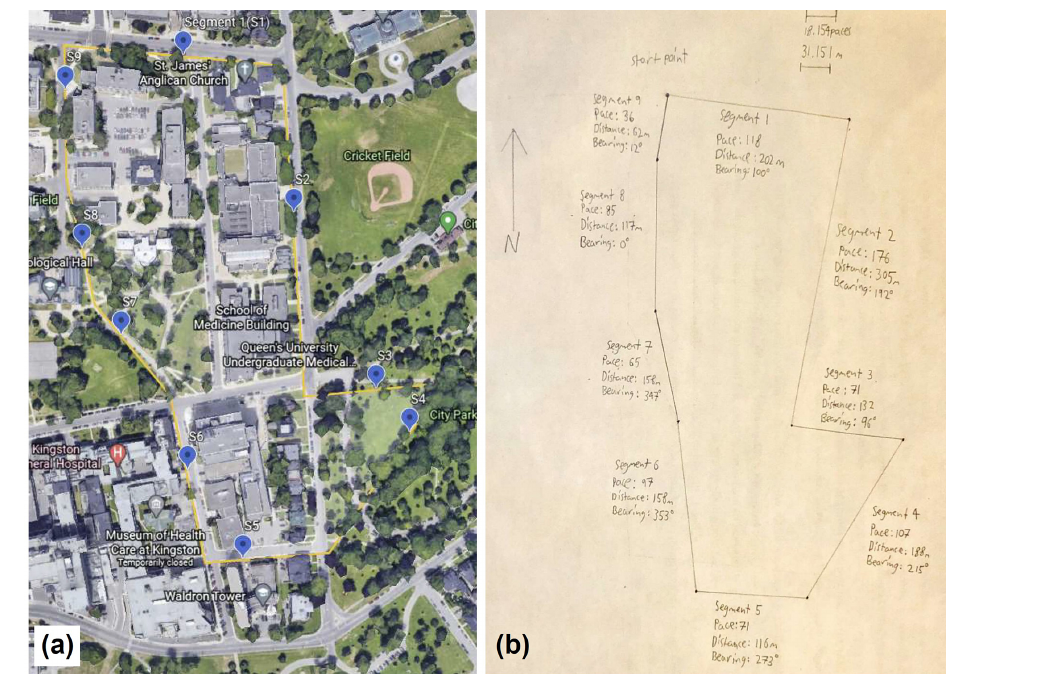
Figure 4. Example lab submission of independent outdoor closed-loop traverse lab. (a) © Google Earth satellite image map (© Google 2021), with a traverse plan and (b) hand-drafted traverse